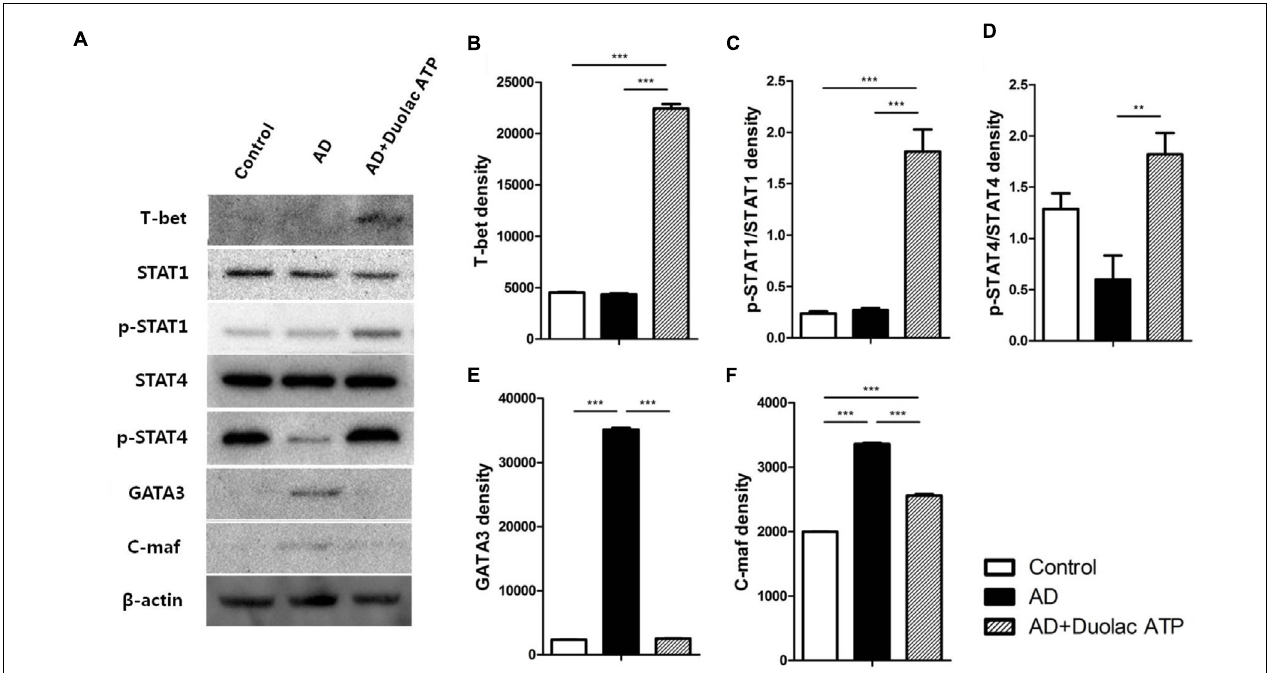
FIGURE 4 | Expression changes on transcriptional factors involved in the maintenance of T cell balance in AD mice administered Duolac ATP. Nc/Nga mice ( n = 6 per group) were sensitized by exposing them to HDM extracts twice a week for 3 weeks. They were then subjected to oral administration of Duolac ATP. PBMCs collected at week 4 were used to make lysates, which were used to examine the expression of transcriptional factors using Western blotting. (A) The expression of T-bet, STAT1, p-STAT1, STAT4, p-STAT4. GATA-3, C-maf, and beta-actin as an internal control are shown. Density was measured using a densitometer for semi-quantitation for (B) T-bet, (C) STAT1, (D) STAT4, (E) GATA 3, and (F) C-maf. ∗∗ P < 0.01, ∗∗∗ P < 0.001 using one-way ANOVA with Tukey’s multiple comparison test. Bars indicate mean ±